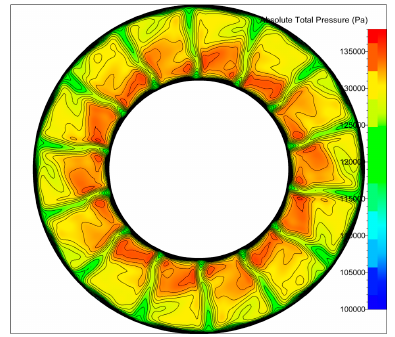
Figure 41. Instantaneous field of total pressure, fan outlet section. Operating point at the nominal rotational speed. (cid:1866)(cid:3364) = 100%.